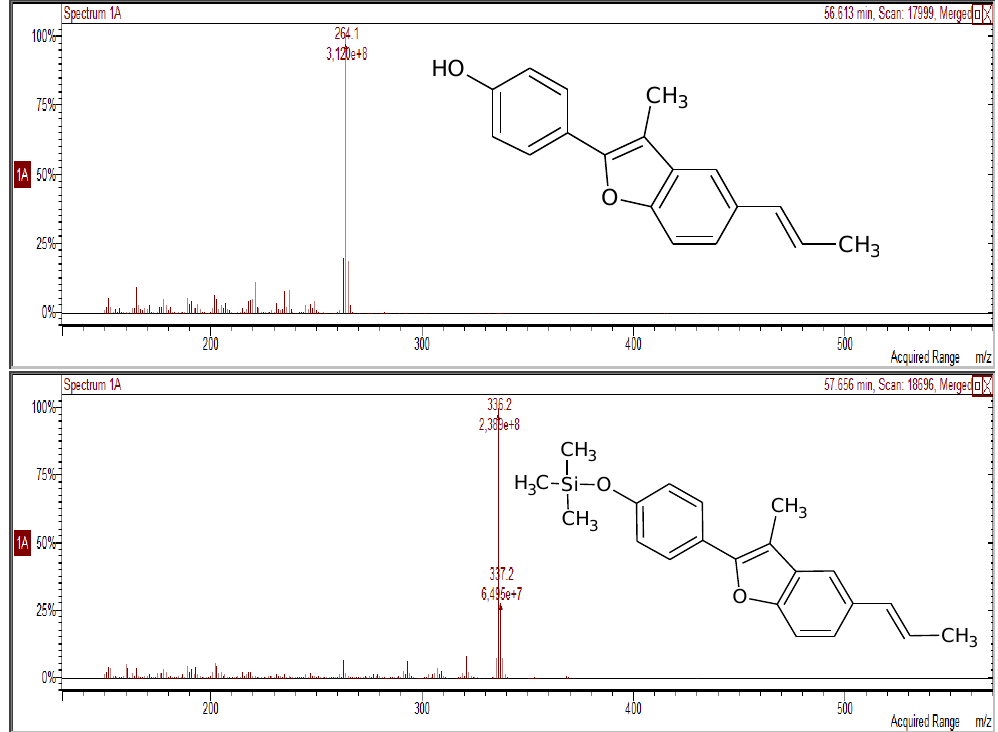
Figure 1. MS analysis of majority peak in 3% fraction 56.61 min, m/z 264 and 57.65 min, m/z 336 (trimethylsililated) corresponding to methylated form of deoxy-kramerixin.